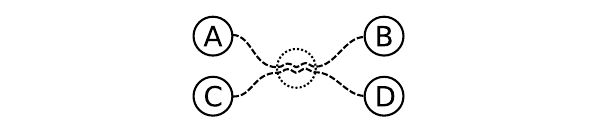
FIGURE 2 | Abstract depiction of two paths, from A to B and from C to D . The two paths, depicted as dashed lines, share some experiences, indicated with a dotted circle, allowing the agent to combine previously experienced episodes into new behavior, e.g., going from A to D. See text for